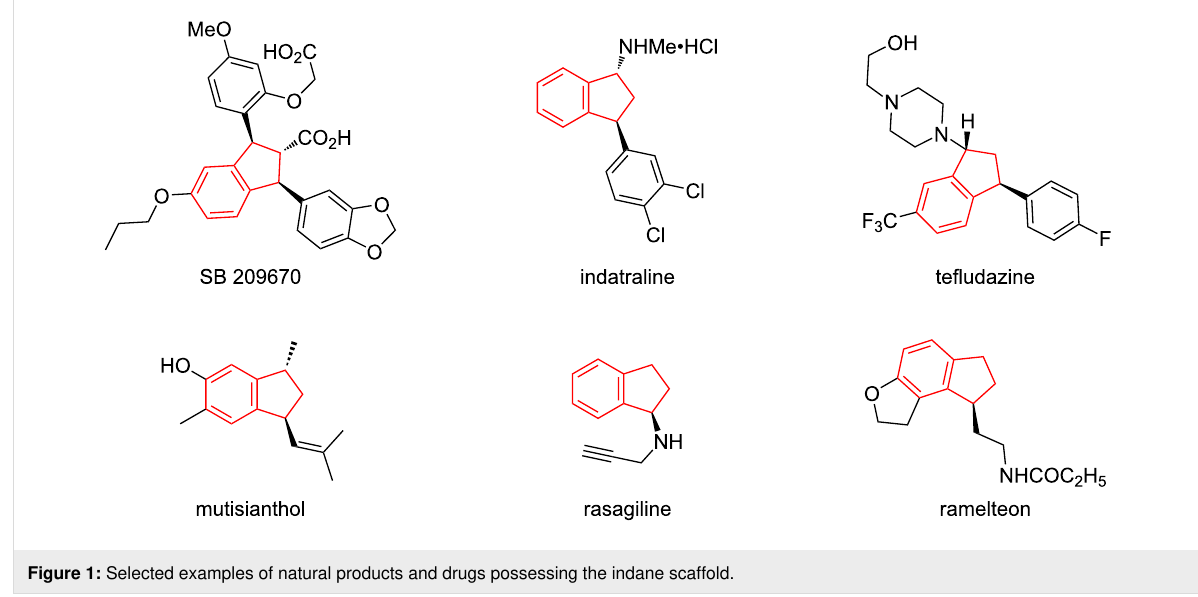
Figure 1: Selected examples of natural products and drugs possessing the indane scaffold.